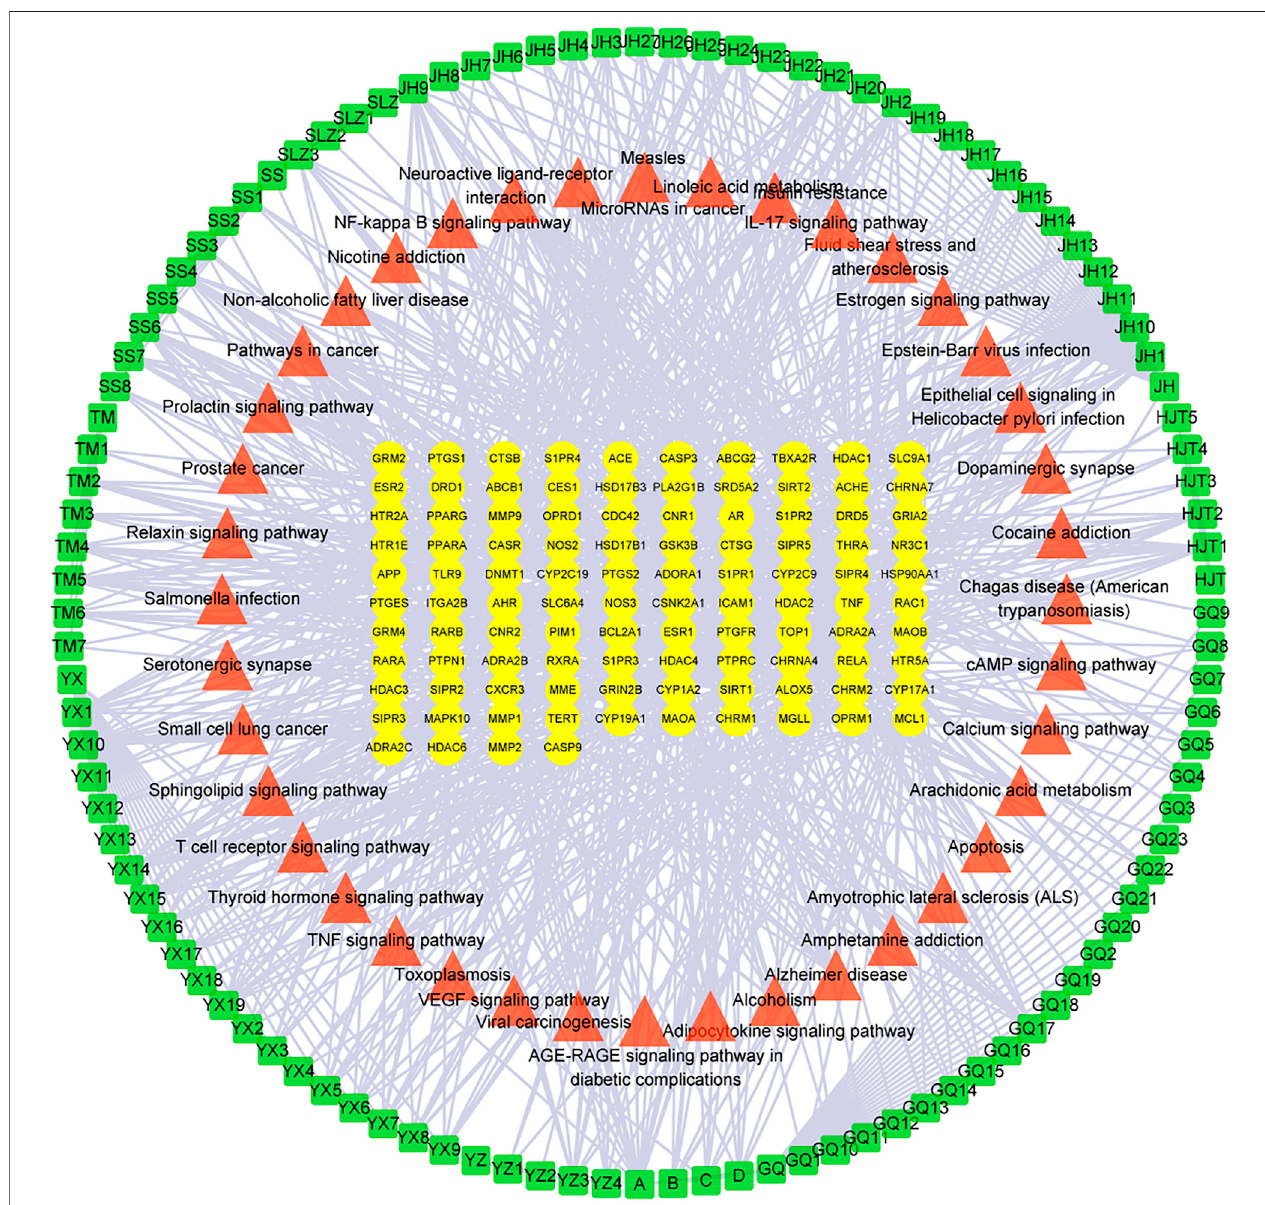
FIGURE 5 | The C-T-P network of Formula 9002A. The outermost green square represents the active component, the red triangle for the pathway, and the yellow oval in the middle for the core targets.